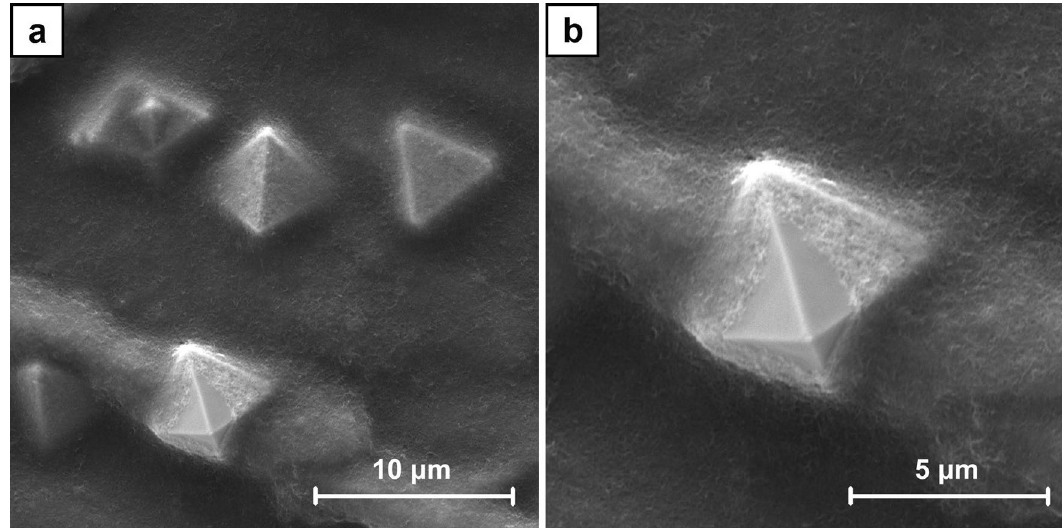
Figure 6. SEM images of the crystals which grew to the surface of CNT layer in B7 sample (ECD deposition time of 600 s, CuSO